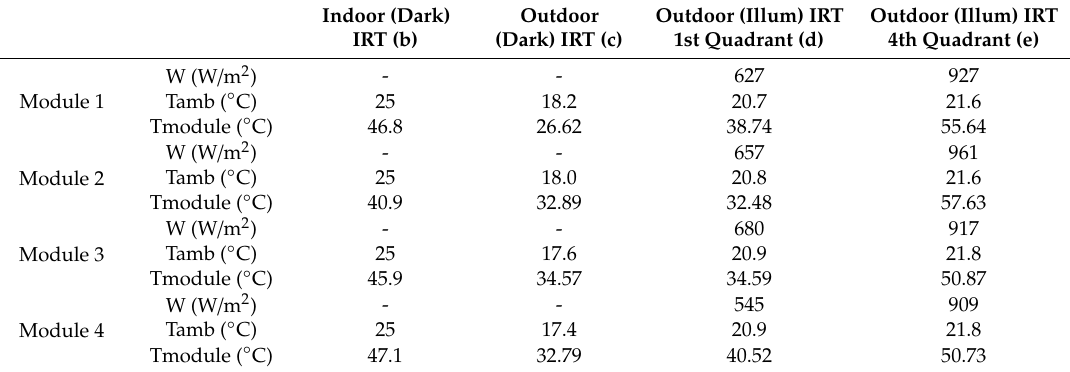
Table 1. Outdoor irradiation, ambient temperature and module temperature of the measurements in modules 1 to 4.